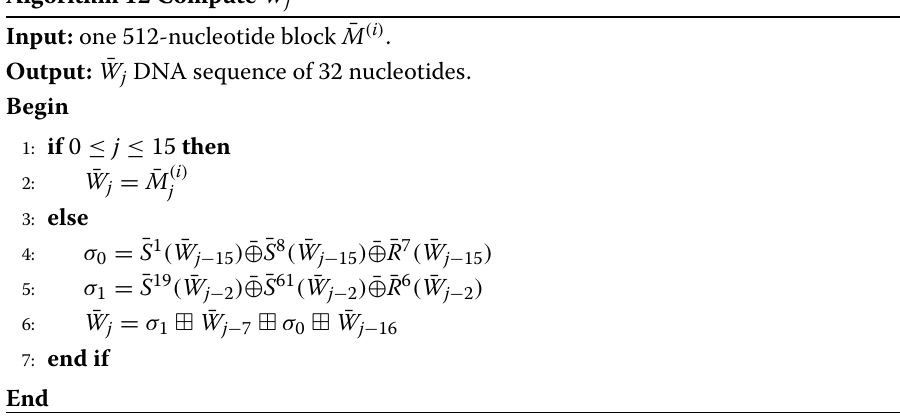
Algorithm 12 Compute